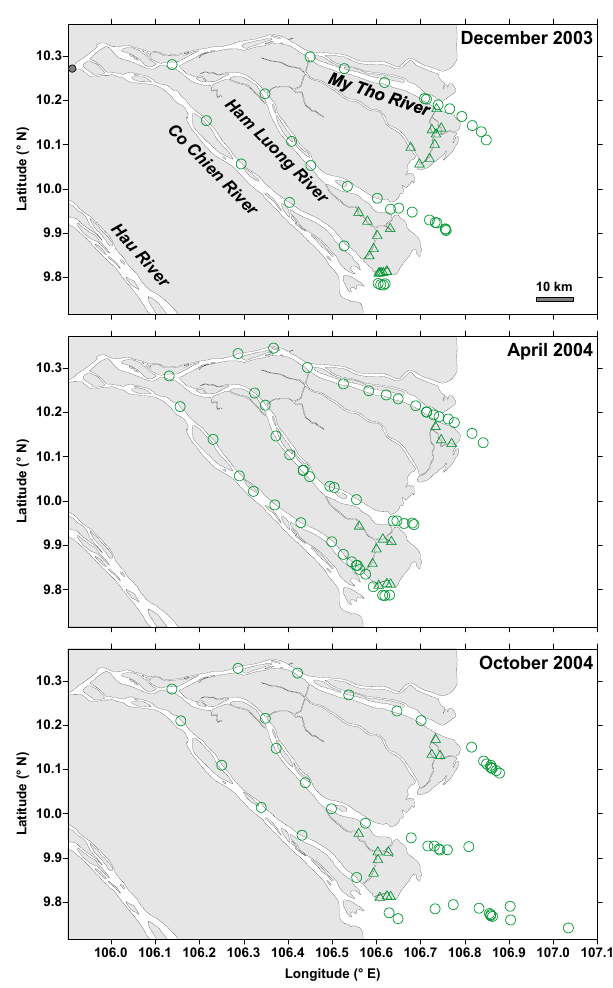
Figure 1. Map of sampling stations in December 2003, April 2004, and October 2004 in the three inner estuarine branches of the Mekong delta (circles) (M e y Tho, Hàm Luông, and C ´ˆ o Chiên) and side channels (triangles). The small grey dot indicates the location of the bridge across the river at the city of V˜ınh Long from which the distance downstream is calculated in Fig.